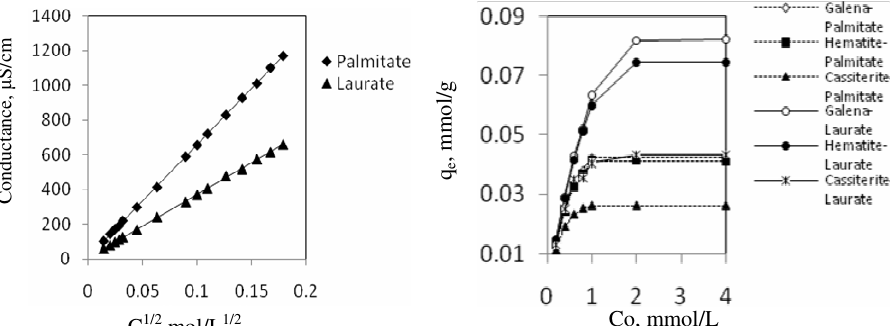
Figure 1. Plot of conductance versus soap concentration